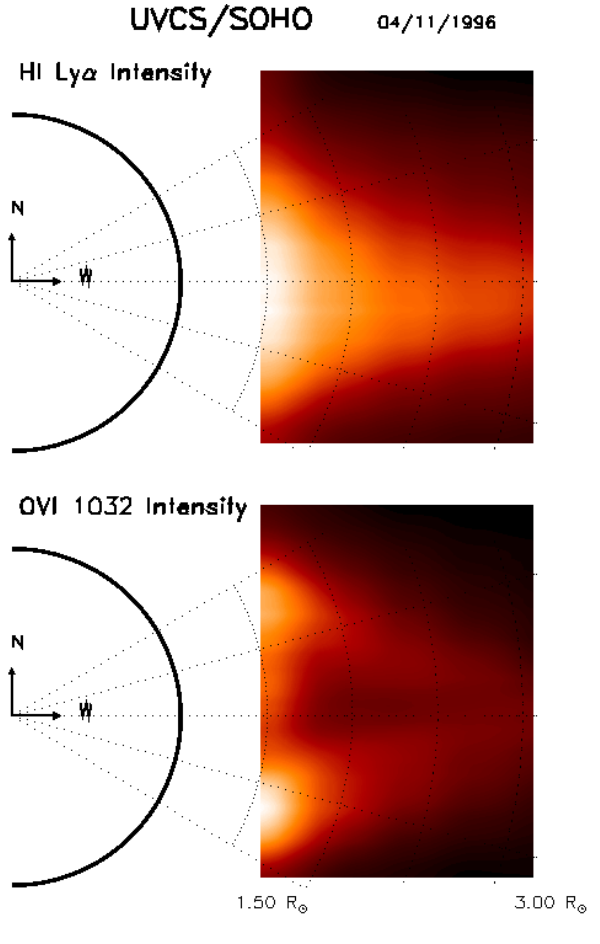
Fig. 1. H I Ly α and O VI 1032 images of the 11 April 1996 equa- torial streamer observed between 1.5 R (cid:12) and 3 R (cid:12) with UVCS. The O VI streamer is certainly formed by two, possibly three, bright structures. The external bright structures are elongated and con- verge toward the interplanetary current sheet beyond 2.5–3 R (cid:12)